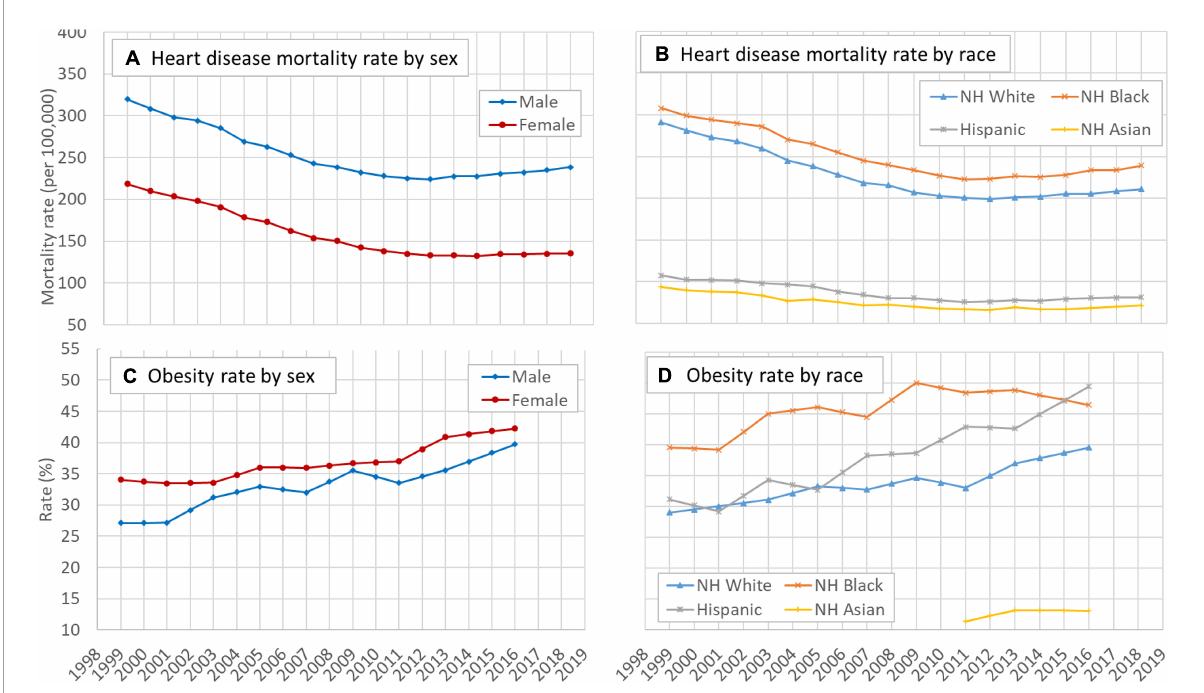
FIGURE1 Time trend of mortality rates of HD and the obesity rate in the US, 25–84 years, 1999–2018, by sex and race. (A) Temporal trend of heart disease mortality rate by sex, (B) temporal trend of heart disease mortality rate by race, (C) temporal trend of obesity rate by sex, and (D) temporal trend of obesity rate by race. HD: Heart disease; NH: Non-Hispanic. Data source: CDC WONDER (https://wonder.cdc.gov/). Data about the obesity rate were derived from the